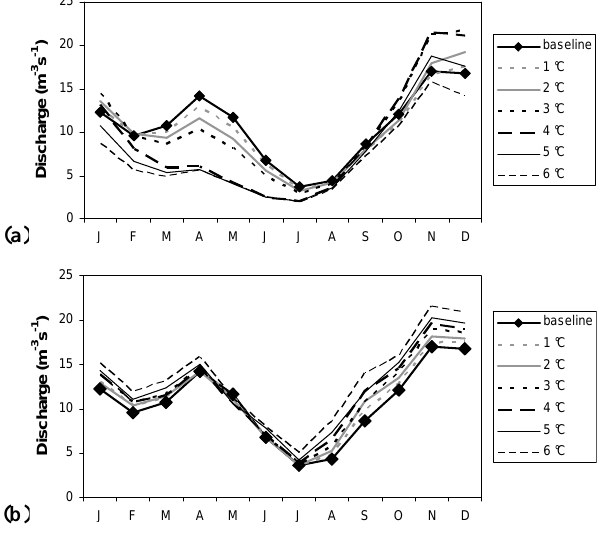
Figure 7 Fig. 7. Comparison of baseline and scenario (a) temperature and (b) precipitation for the 2 ◦ C prescribed increases in global mean temperature across 7